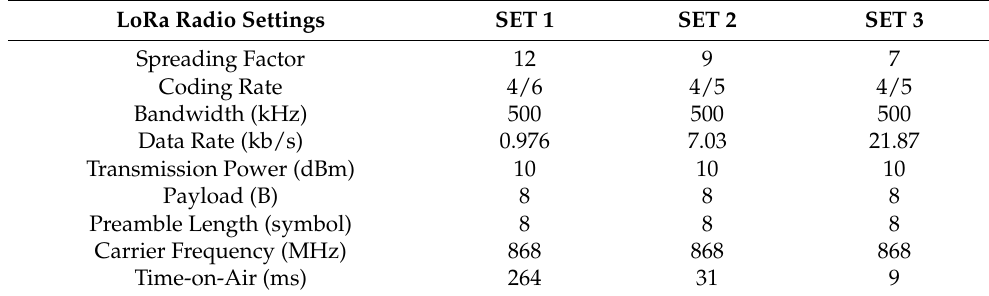
Table 1. LoRa radio settings